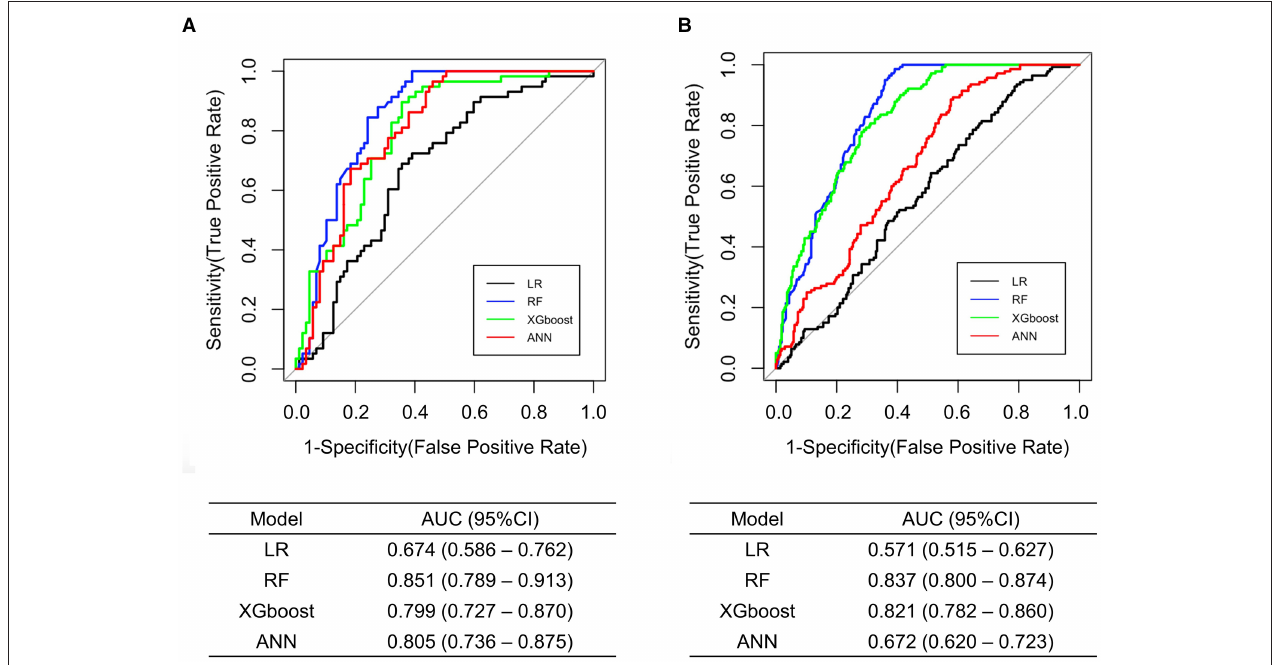
FIGURE 3 | Comparison of the ROC curves and the AUC among the developed models for MH/MUCH prediction in internal (A) and external validation (B) . ANN, artificial neural network; AUC, area under the curve; CI, confidence interval; LR, logistic regression; MH/MUCH, masked hypertension/masked uncontrolled hypertension; RF, random forest; ROC, receiver operating characteristic; XGboost, eXtreme Gradient Boosting.